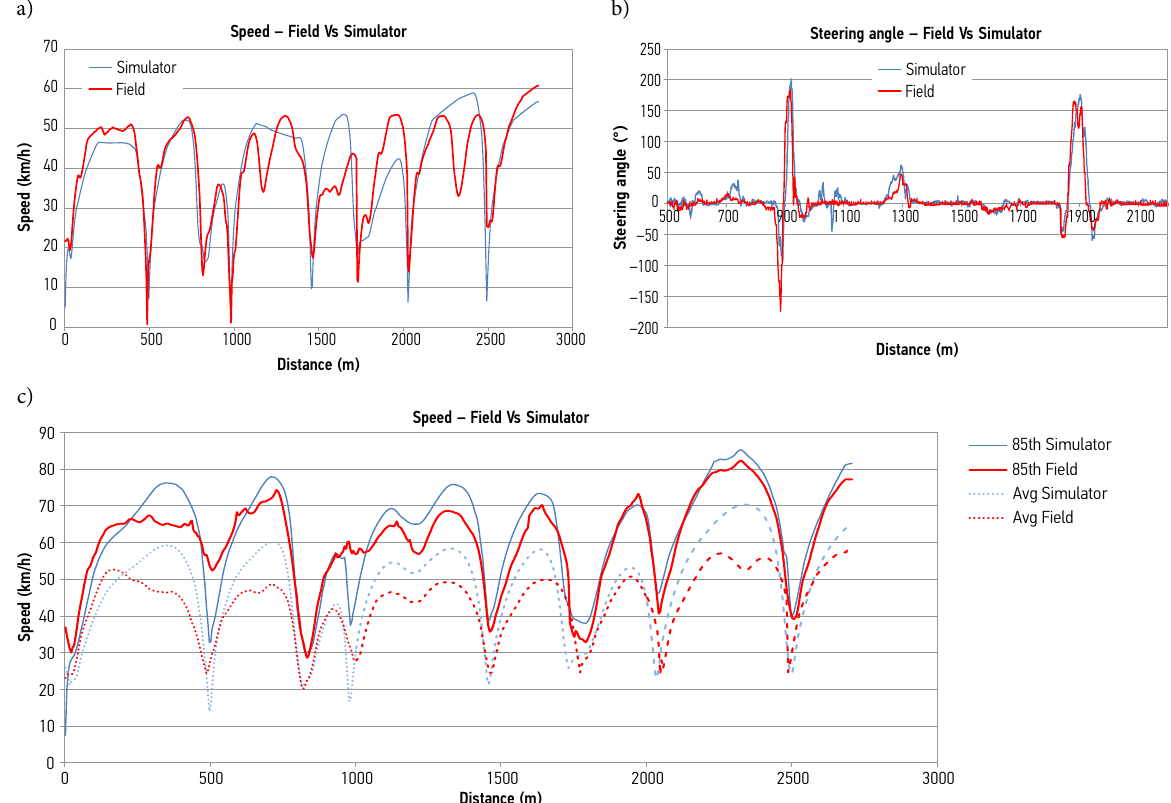
Fig. 7. comparison among field and simulated data: a – single driver speed; b – single driver steering angle; c – 85-th percentile and mean of